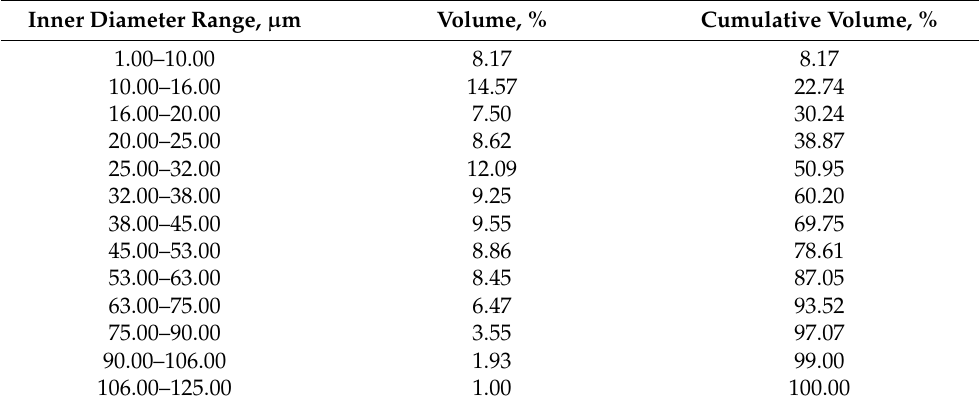
Table 6. Granulometry of aluminum oxide powder.